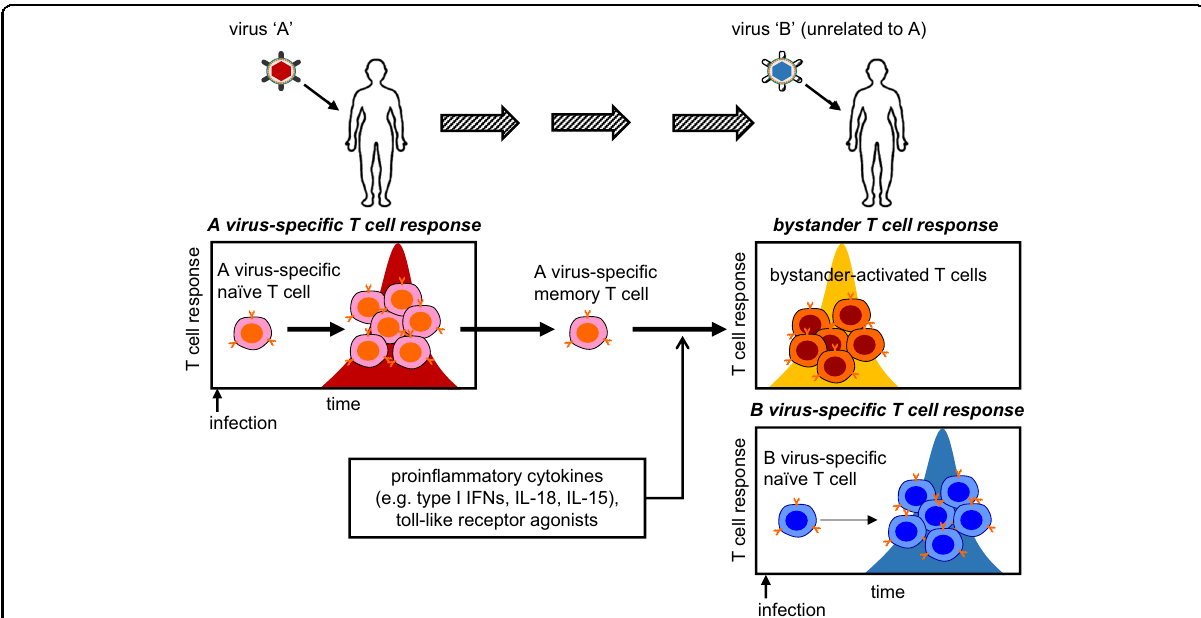
Fig. 1 Bystander activation of memory T cells during viral infections. Upon infection with a virus “ A, ” naive T cells speci fi c for the virus undergo a T cell receptor (TCR)-dependent clonal expansion and then a contraction, leaving memory T cells. Next, infection with an unrelated virus “ B ” induces TCR-dependent responses as well as TCR-independent “ bystander activation ” of virus A-speci fi c memory T cells. This bystander response is rapidly induced by cytokines or Toll-like receptor agonists. Type I IFNs, type I interferons; IL-18, interleukin-18; IL-15,